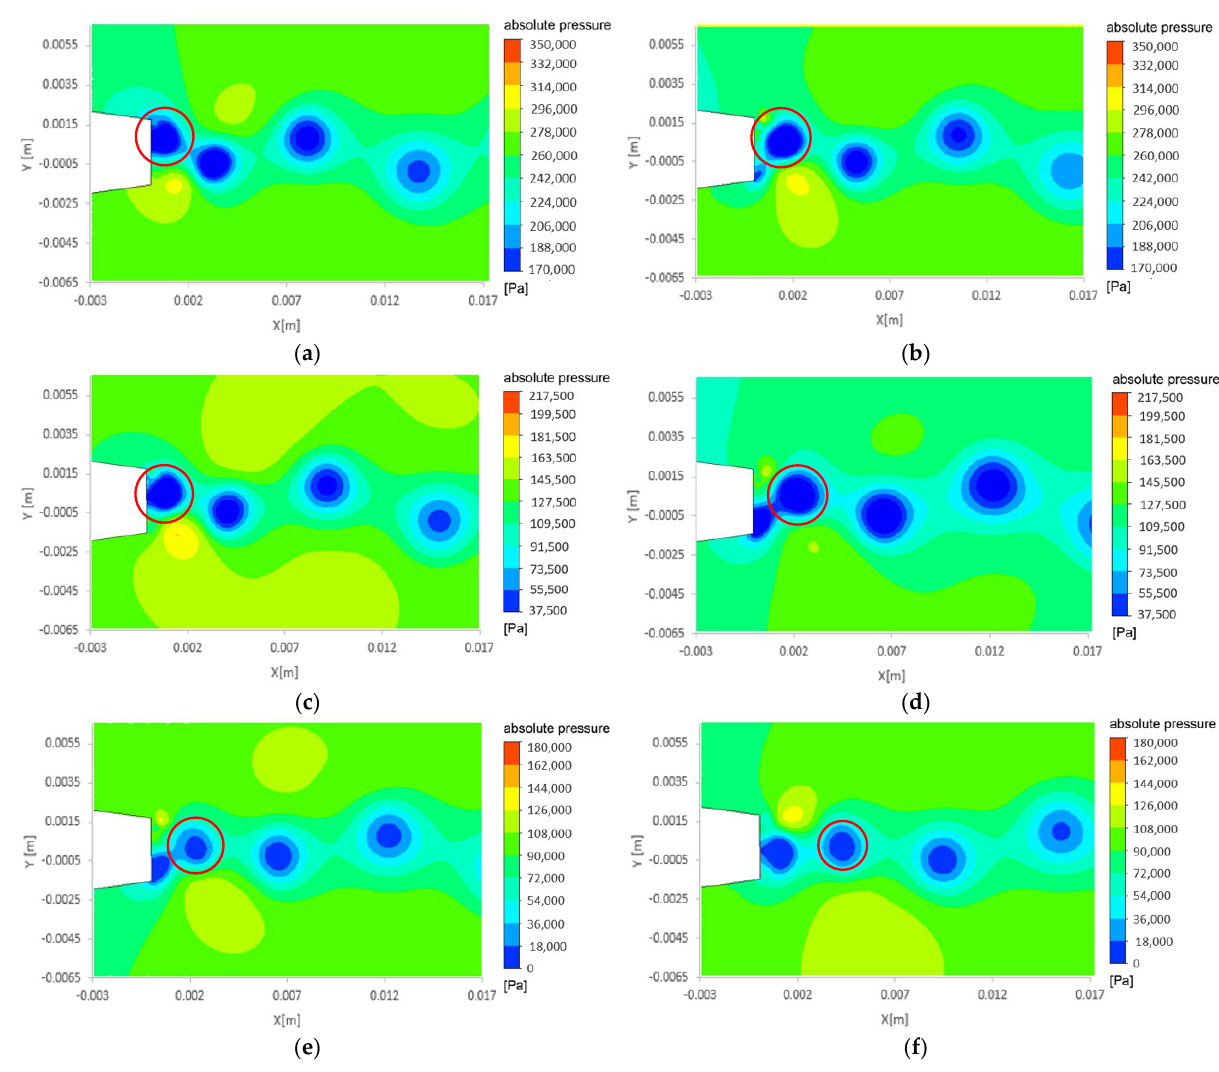
(a,b), ( c , d ), and ( e , f ) regimes at t/T = 0 ( a , c , e ) and t/T = 0.25 = 2 (a,b), σ = 0.98 ( c , d ), and σ = 0.69 ( e , f ) regimes at t / T = 0 ( a , c , e ) and σ i σ i σ i 𝜎𝜎 𝜎𝜎 𝜎𝜎 𝜎𝜎 𝑖𝑖 = 2 𝜎𝜎 𝑖𝑖 = 0.98 𝜎𝜎 𝑖𝑖 = 0.69